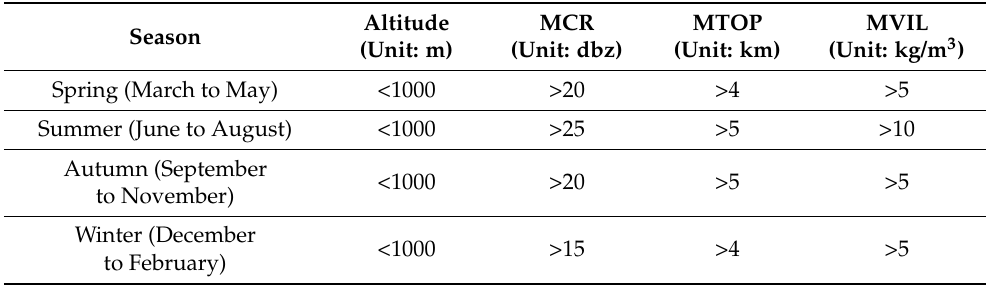
Table 2. Rainfall enhancement criteria for stratiform and cumulus mixed clouds.